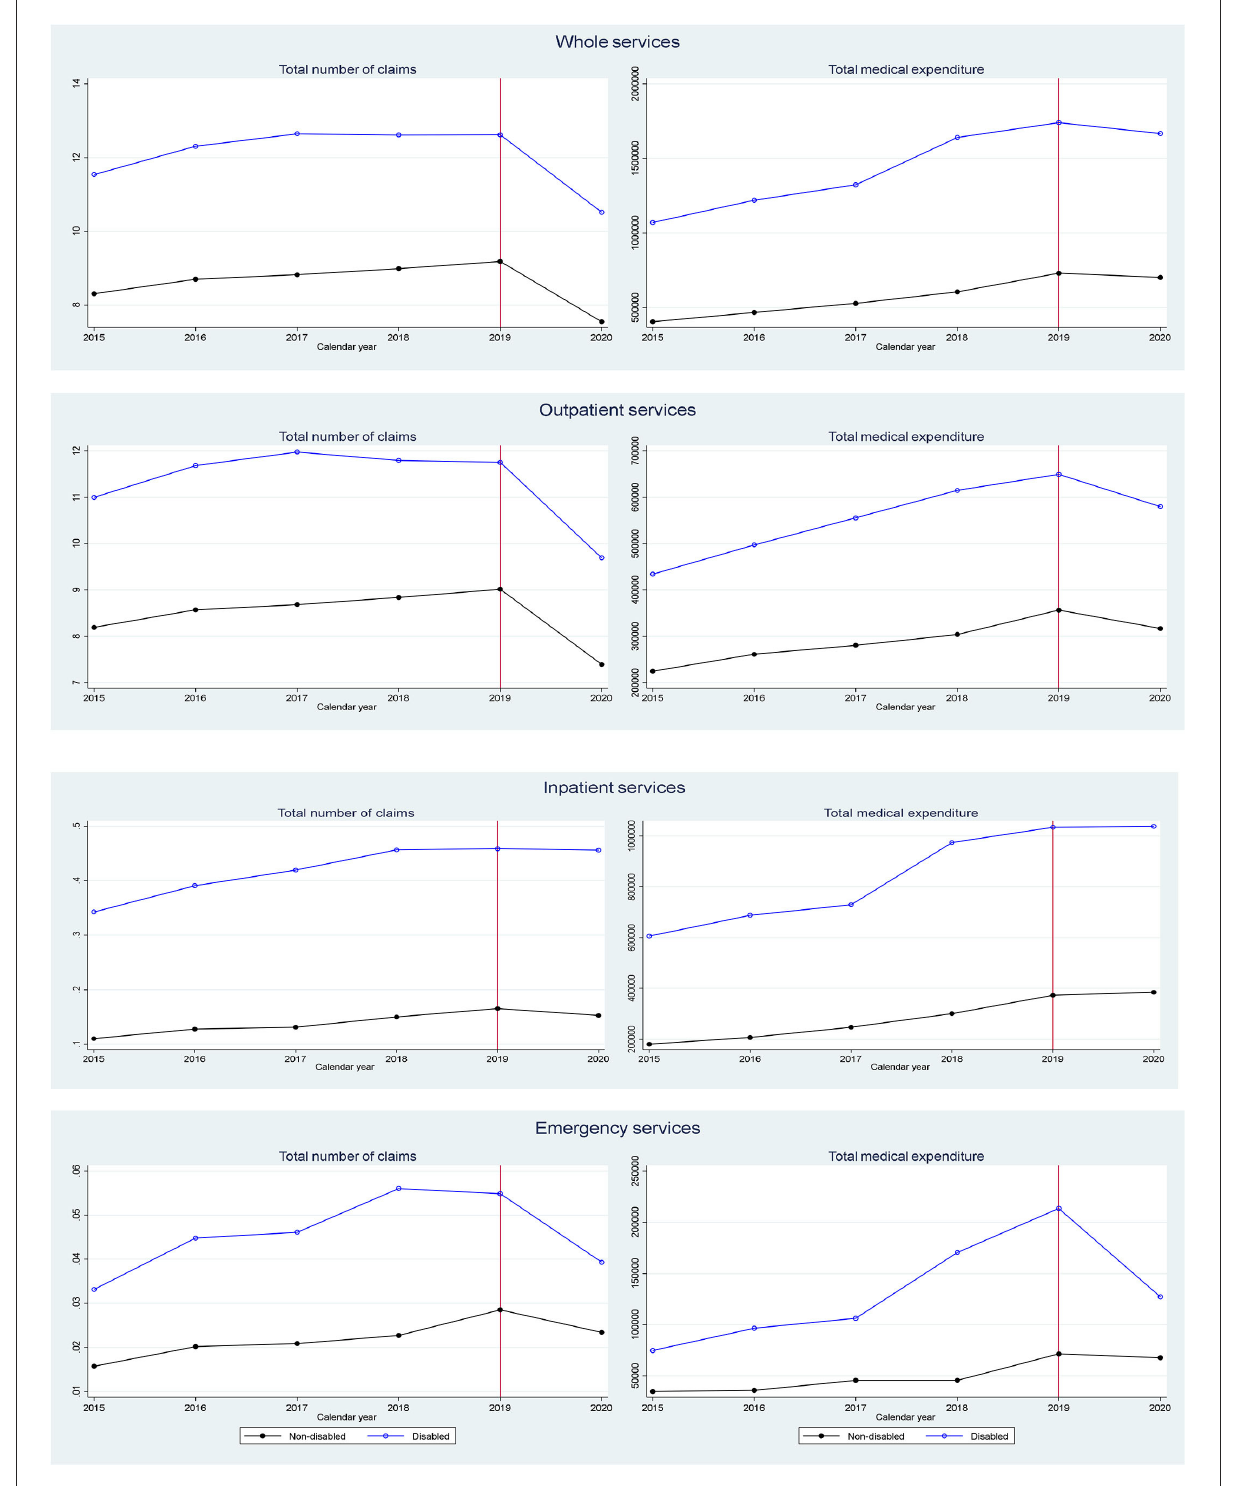
FIGURE2 Average healthcare utilization trend for 5 months of each year pre- and post-outbreak of